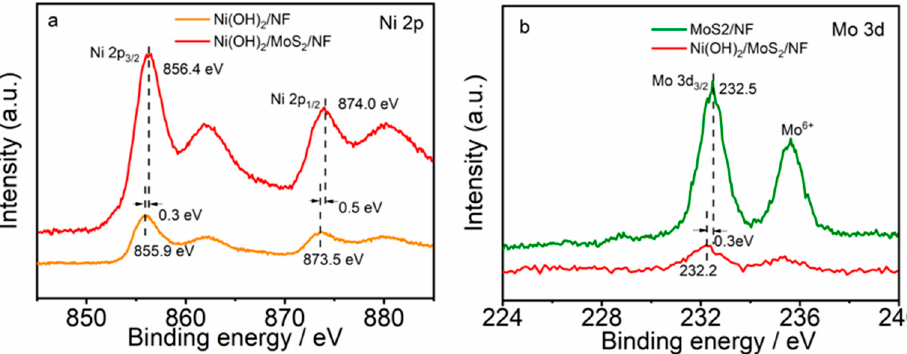
Figure 7. XPS spectra of ( a ) Ni 2p, ( b ) Mo 3d of Ni(OH) 2 , MoS 2 and Ni(OH) 2 /MoS 2 /NF electrodes.